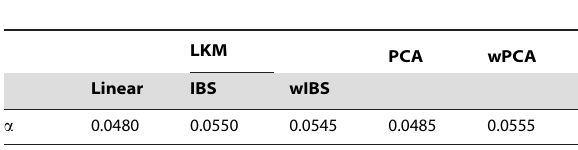
Table 3. Empirical type I error rates for LKM, PCA and wPCA in Scenarios